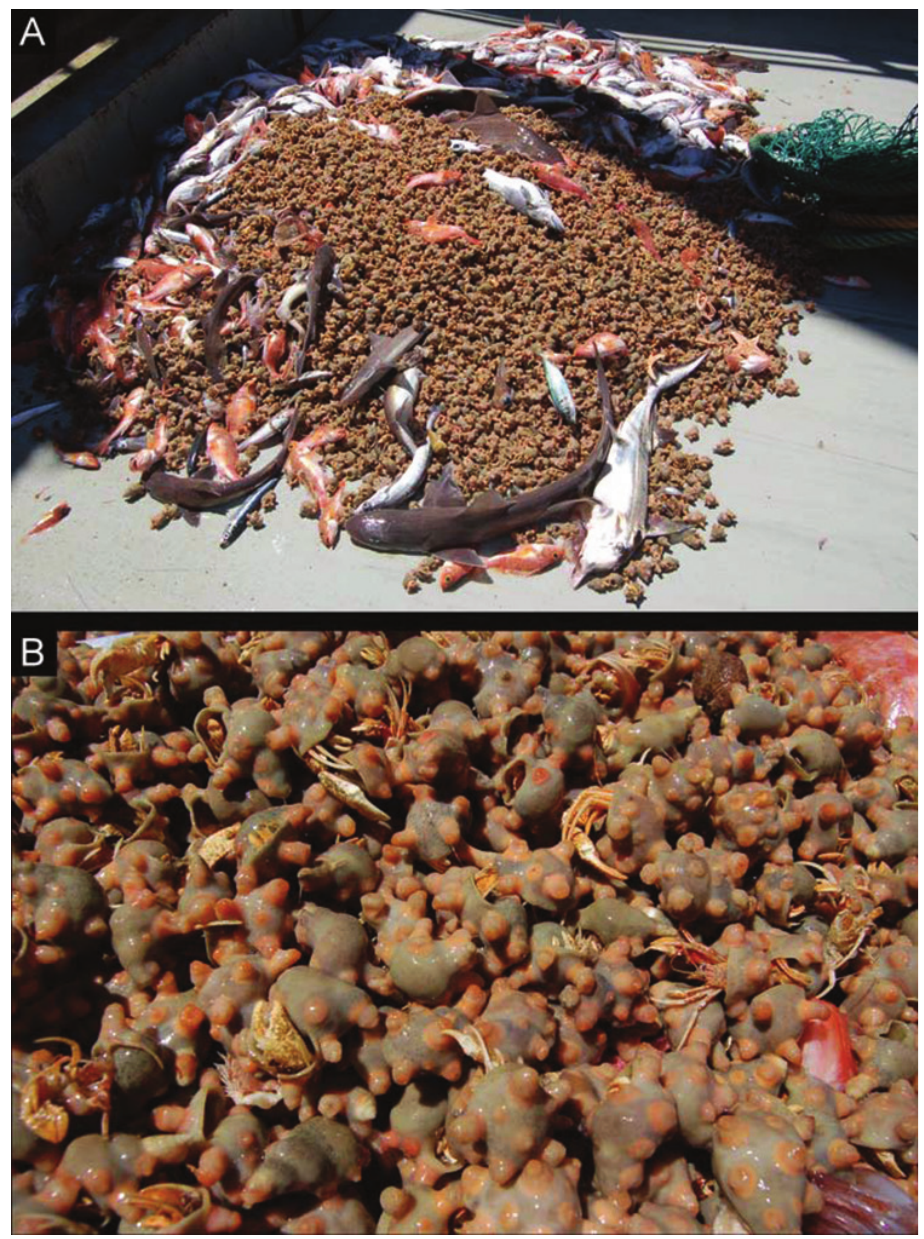
Figure 1. Abundance of deep-water hermit crabs in South African demersal research survey, Agulhas Bank, South Africa, Nan2007 401, sta 1294–008, S35°24.40', E19°10.70', 227 m, 12 Jan 2007: A con- tents of one trawl showing catch B close-up of parapagurid specimens and anthozoan symbionts (colonies of Epizoanthus sp.) in same. (Photographs by Kerry